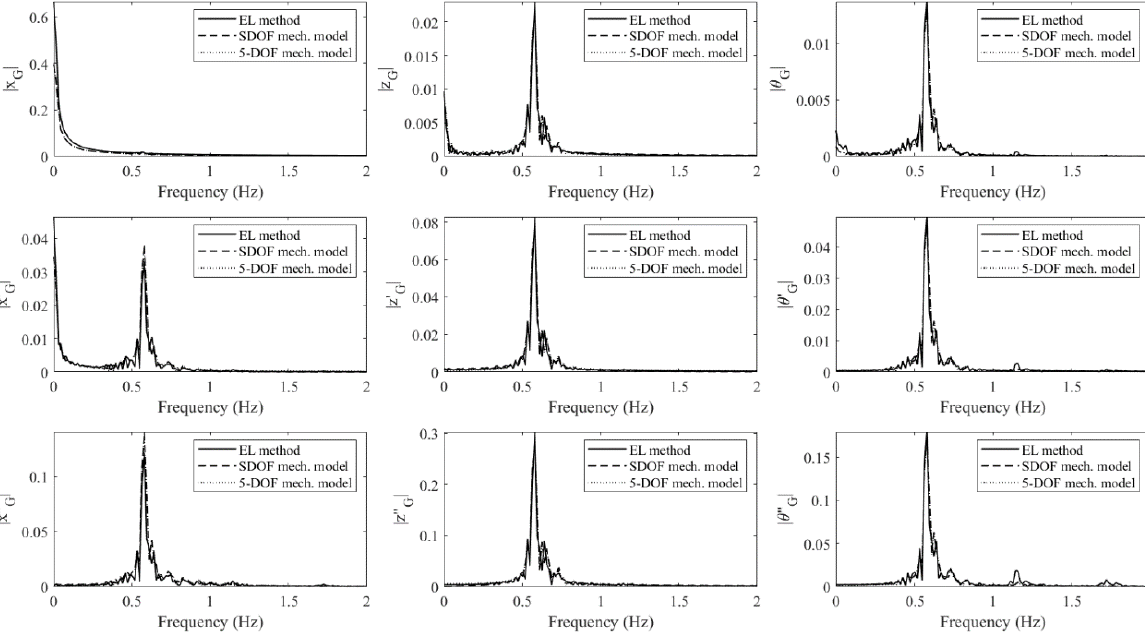
Figure 20. The response spectra of the floating body, configured with a water tank installed with porous media, undergoing large wave excitation.